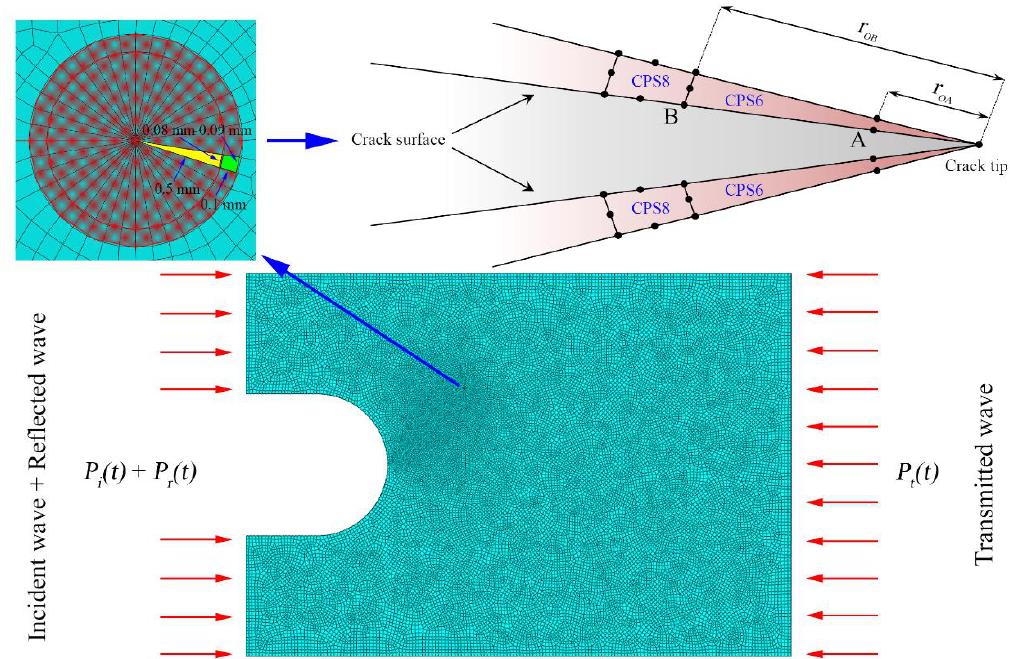
Figure 9. A numerical model of the specimen in ABAQUS.